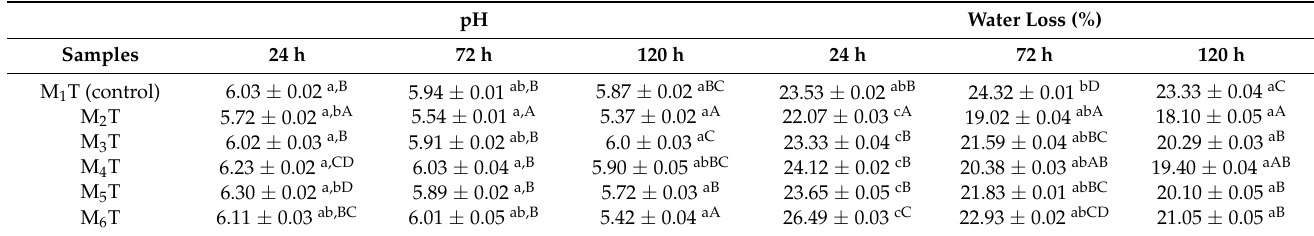
Table 8. pH and water loss of the cooked meat